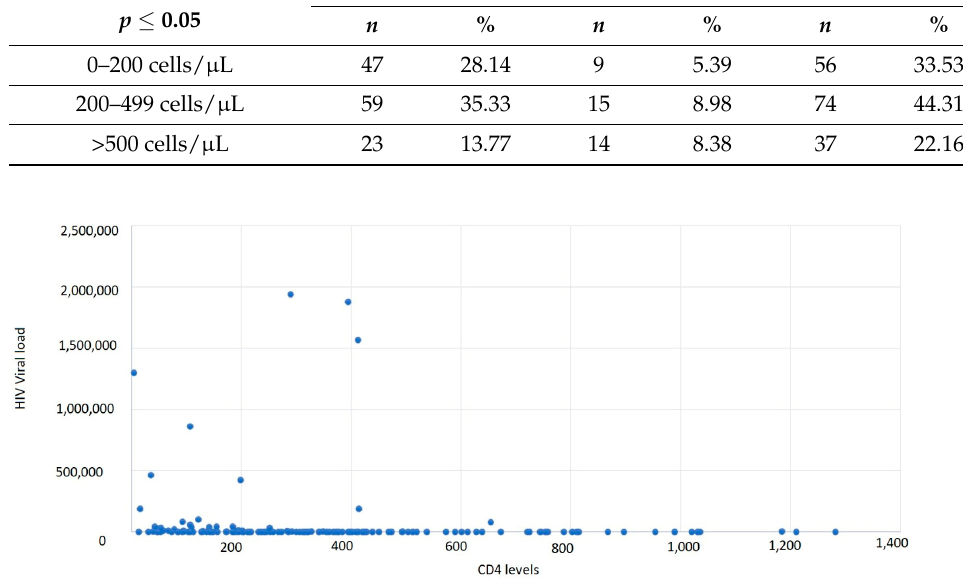
Figure 5. Distribution of HIV/AIDS cases by CD4+ T-lymphocytes level and HIV viral load, one month after ART.